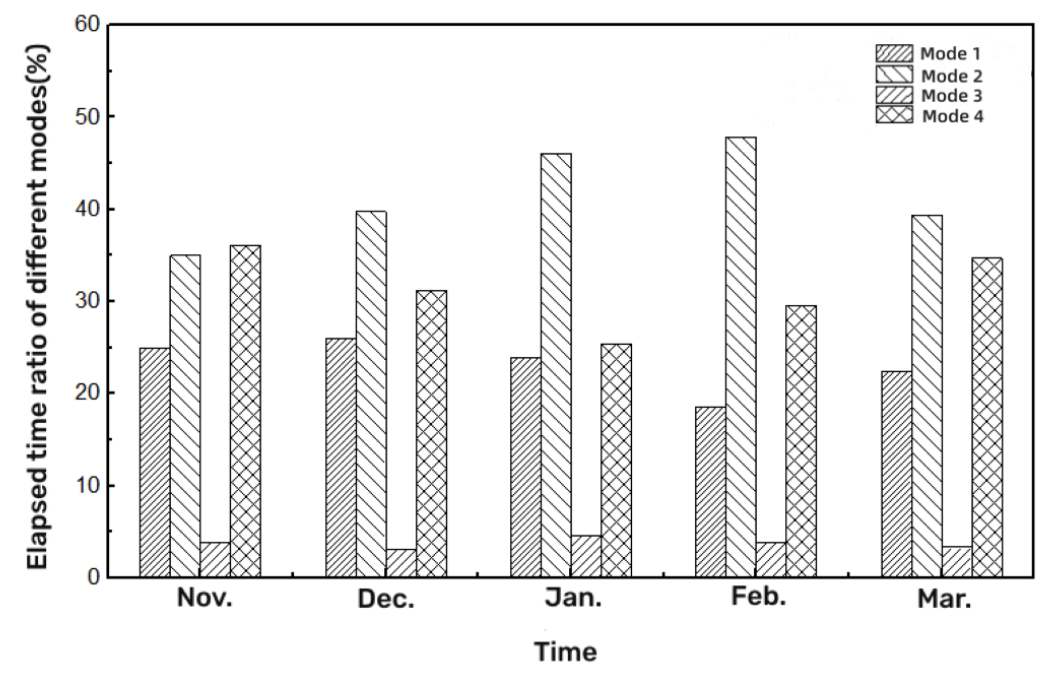
Figure 6. Proportion of operating hours of different heating modes in each month.